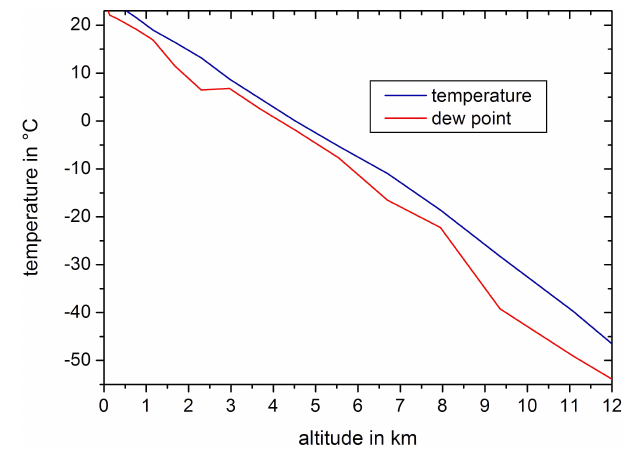
Figure 8. Initial dry aerosol particle number size distributions: Number concentrations per cm 3 and µm as a function of particle